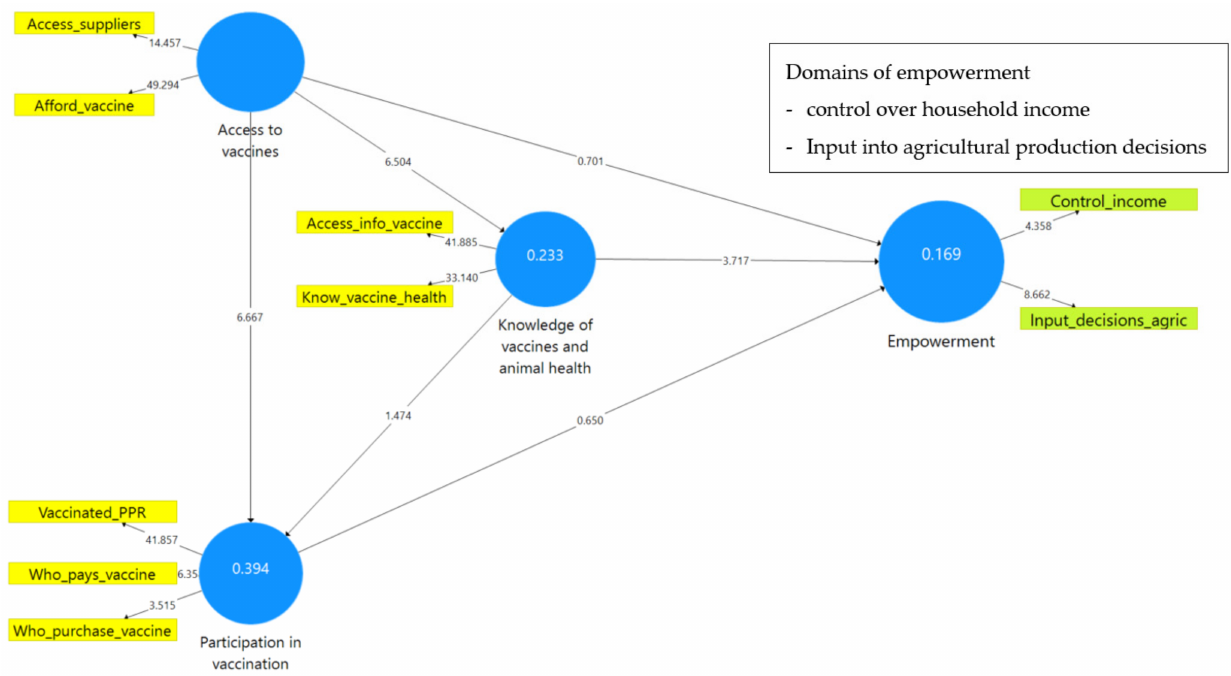
Figure 4. PLS-SEM model results from men